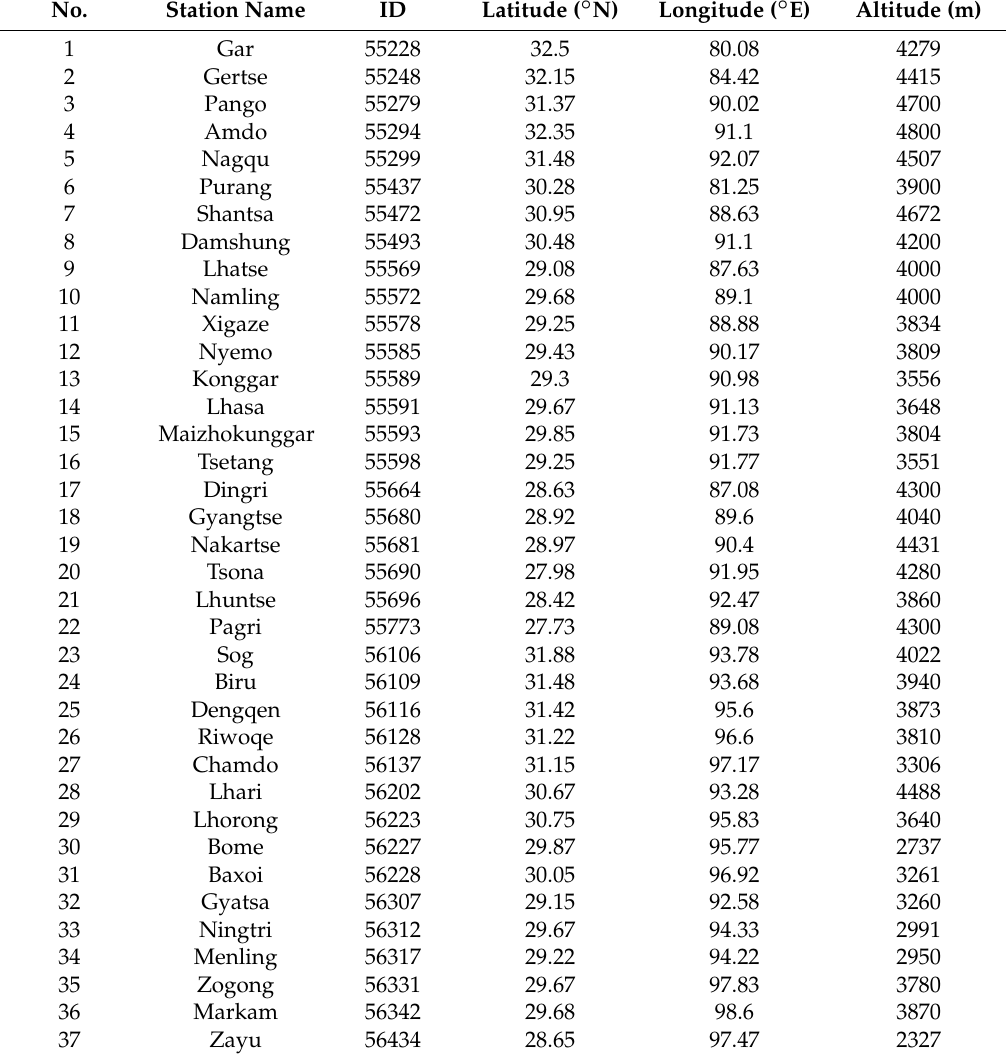
Table A1. Information about the 37 meteorological stations in the Tibet Autonomous